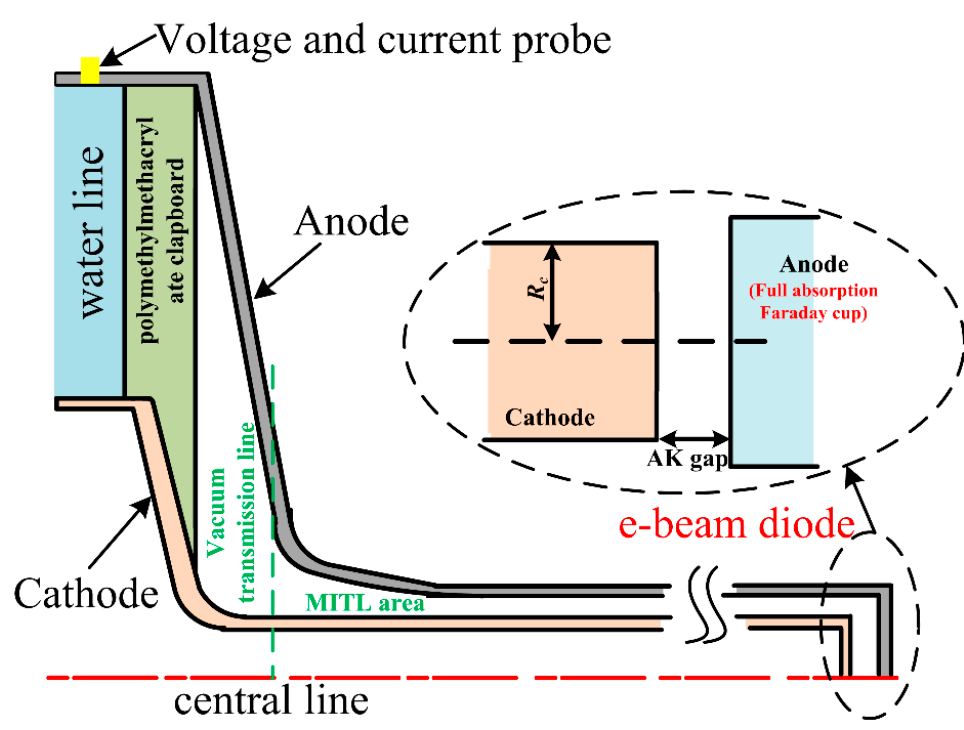
Figure 7. The experimental platform for MITL-driving electron beam diode.